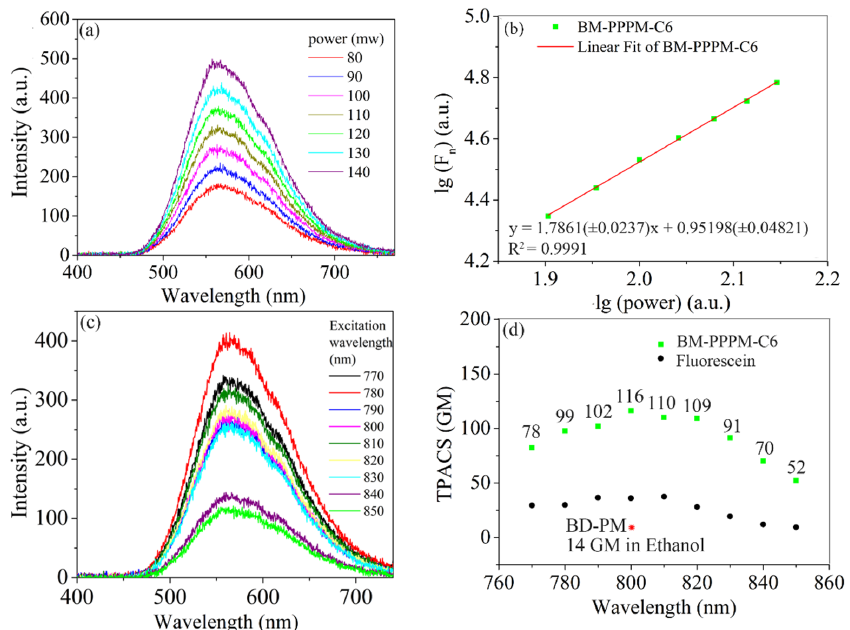
Figure 4. ( a ) Two-photon fluorescence of molecule BM-PPPM-C6 under diverse laser powers at 800 nm in DCM; ( b ) relationship between two-photon fluorescence integration area (F n ) and laser power (mW) of BM-PPPM-C6; ( c ) two-photon fluorescence of molecule BM-PPPM-C6 at diverse excitation wavelengths in DCM; ( d ) TPACS: δ TPA (1 GM = 10 − 50 cm 4 ·s/photon) at diverse wavelengths of molecule BM-PPPM-C6 in DCM.